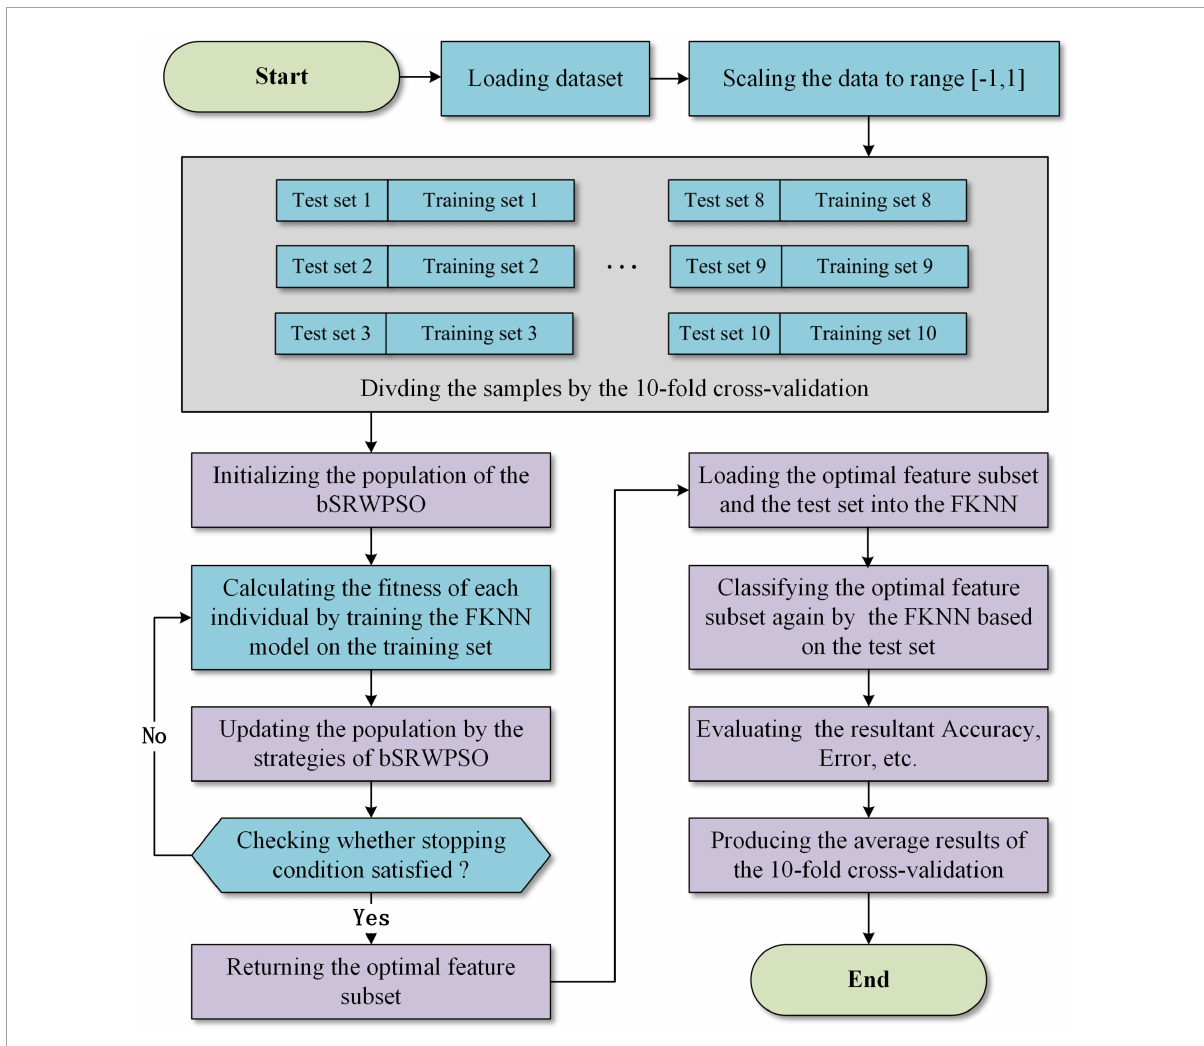
FIGURE3 The basic workflow of the